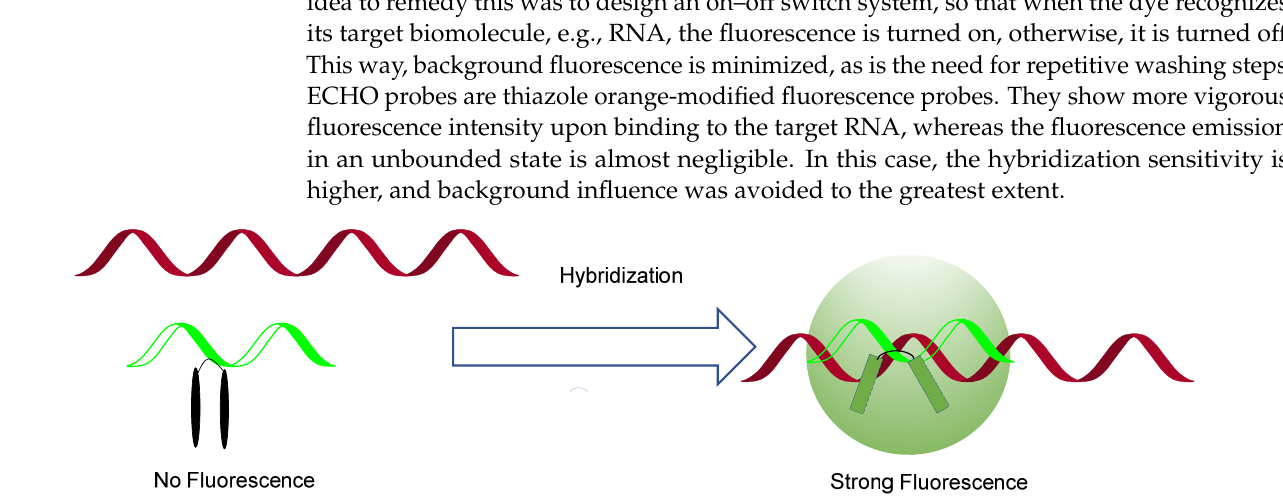
Figure 2. Schematic illustration of exciton-controlled hybridization-sensitive fluorescent oligonu- cleotide (ECHO) probes. Red stands for target RNA, and green is the ECHO probe.